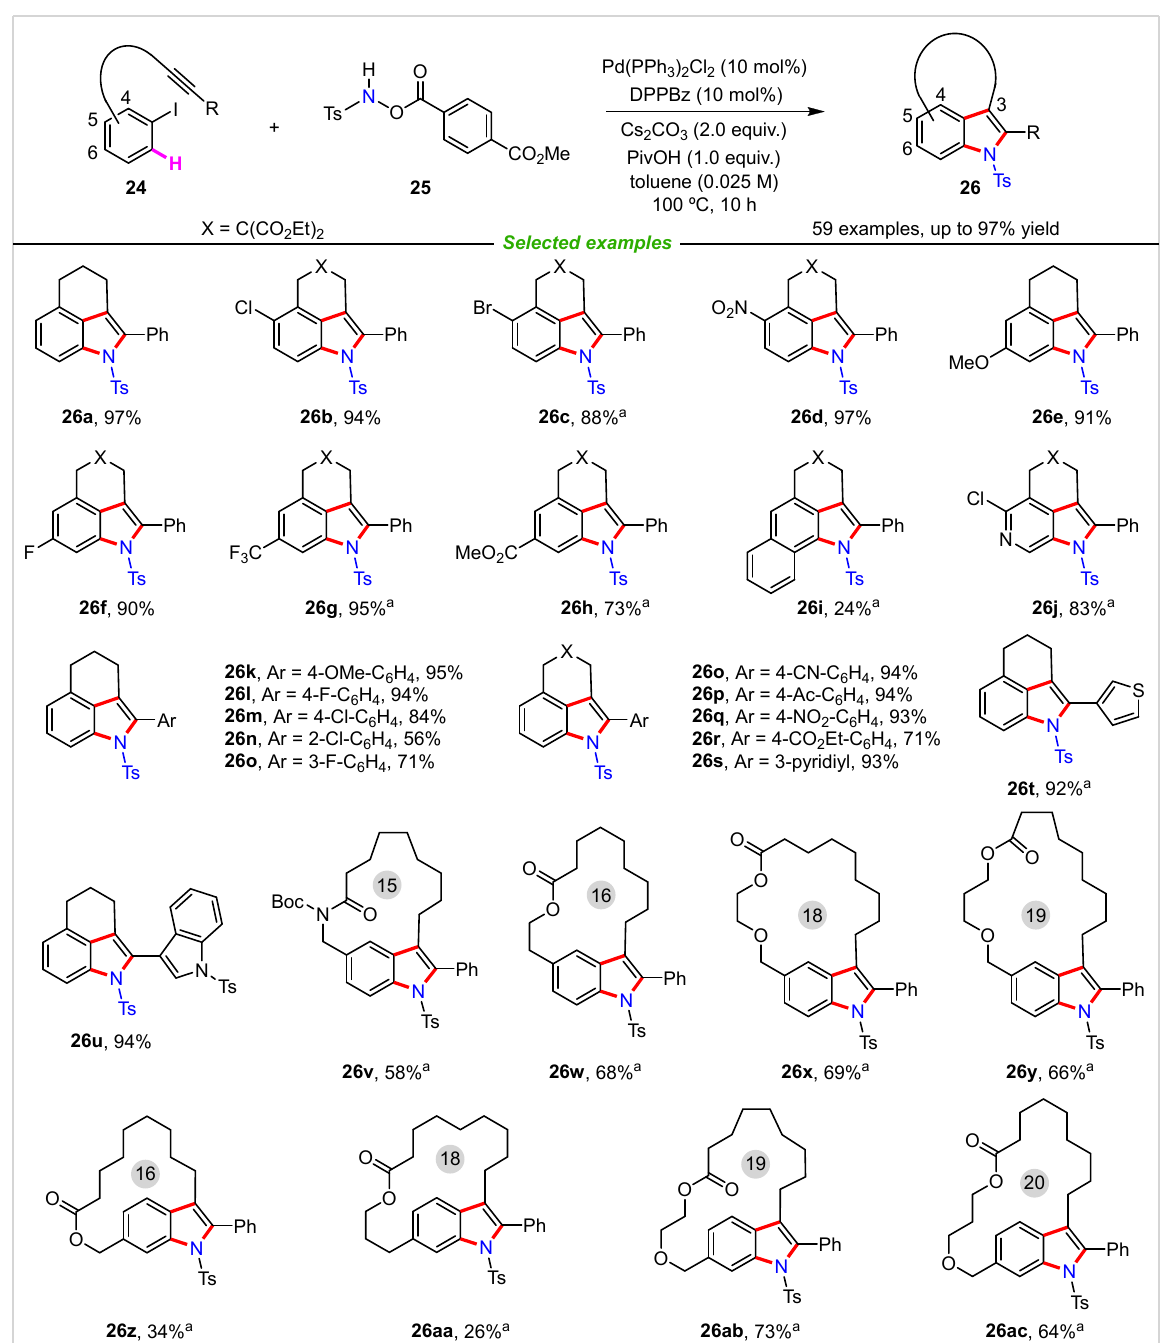
Scheme 11. Palladium-catalyzed [2 + 2 + 1] annulation with internal alkyne tethered aryl iodide